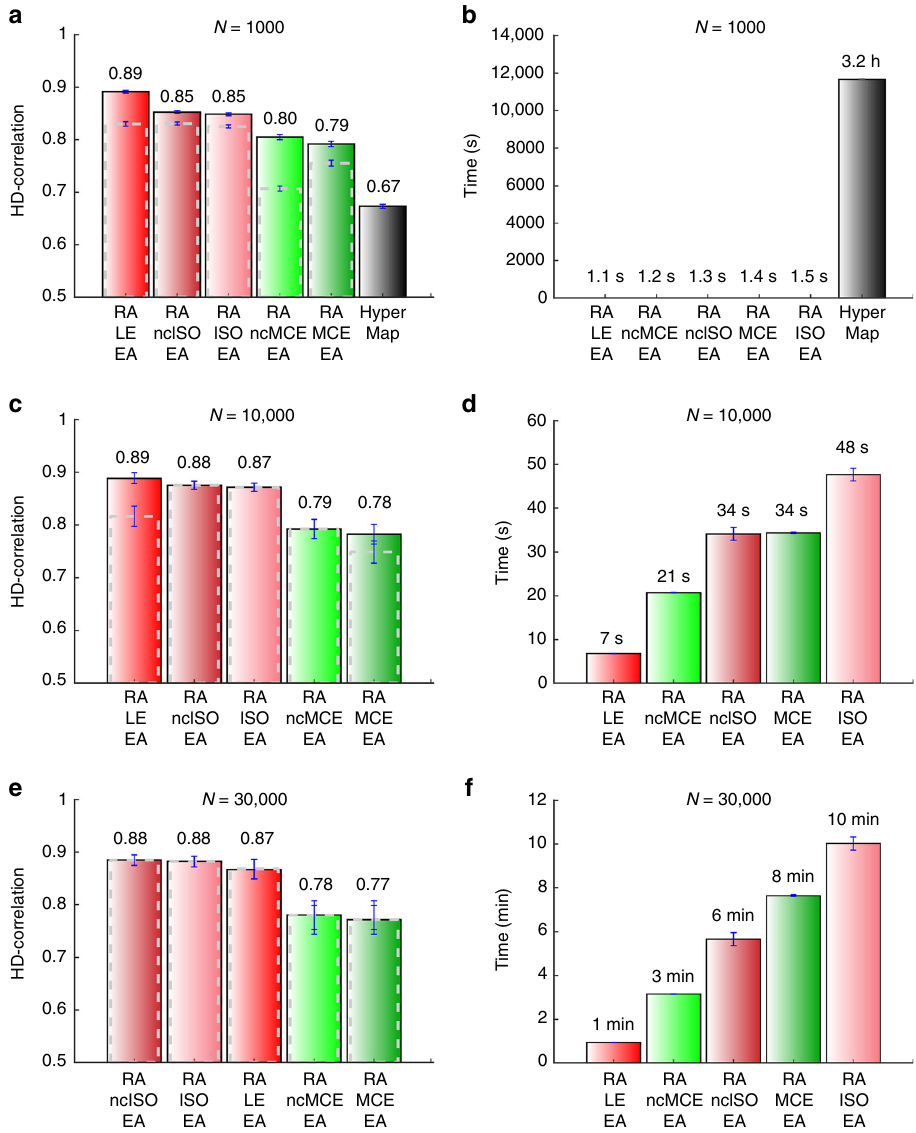
Fig. 5 Comparison of HD-correlation and time on small and large-size popularity-similarity-optimization synthetic networks. a , c , e Average performance and standard error, measured as HD-correlation, for all PSO networks of sizes N = 1000, N = 10,000, and N = 30,000, respectively. Averages are taken over the parameters m (half of the mean node degree) and temperature T . b , d , f Average computation times for the PSO networks of sizes N = 1000, N = 10,000, and N = 30,000, respectively. Again, averages are taken over the parameters m (half of the mean node degree) and temperature T . Considering the average performance in all the simulations on 1000 nodes networks a , coalescent embedding approaches achieved a performance improvement of more than 30% in comparison to HyperMap, requiring only around one second versus more than three hours of computation time. Similar performance results are con fi rmed for the networks of sizes N = 10,000 and N = 30,000 with an execution time still in the order of minutes for the biggest networks. The comparison to HyperMap was not possible due to its long running time. The dashed gray bins represent the HD-correlation of the respective non-EA variants, suggesting that their performance tends to the EA variants for larger PSO